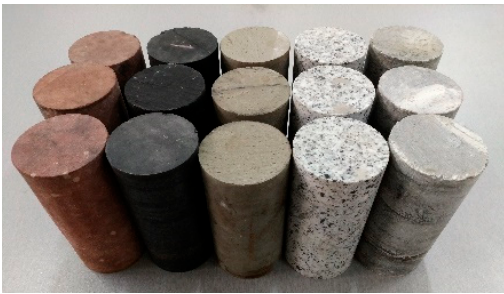
Figure 2. Prepared rock samples for uniaxial cyclic compression tests. Table 1. Physical properties of rock specimens.